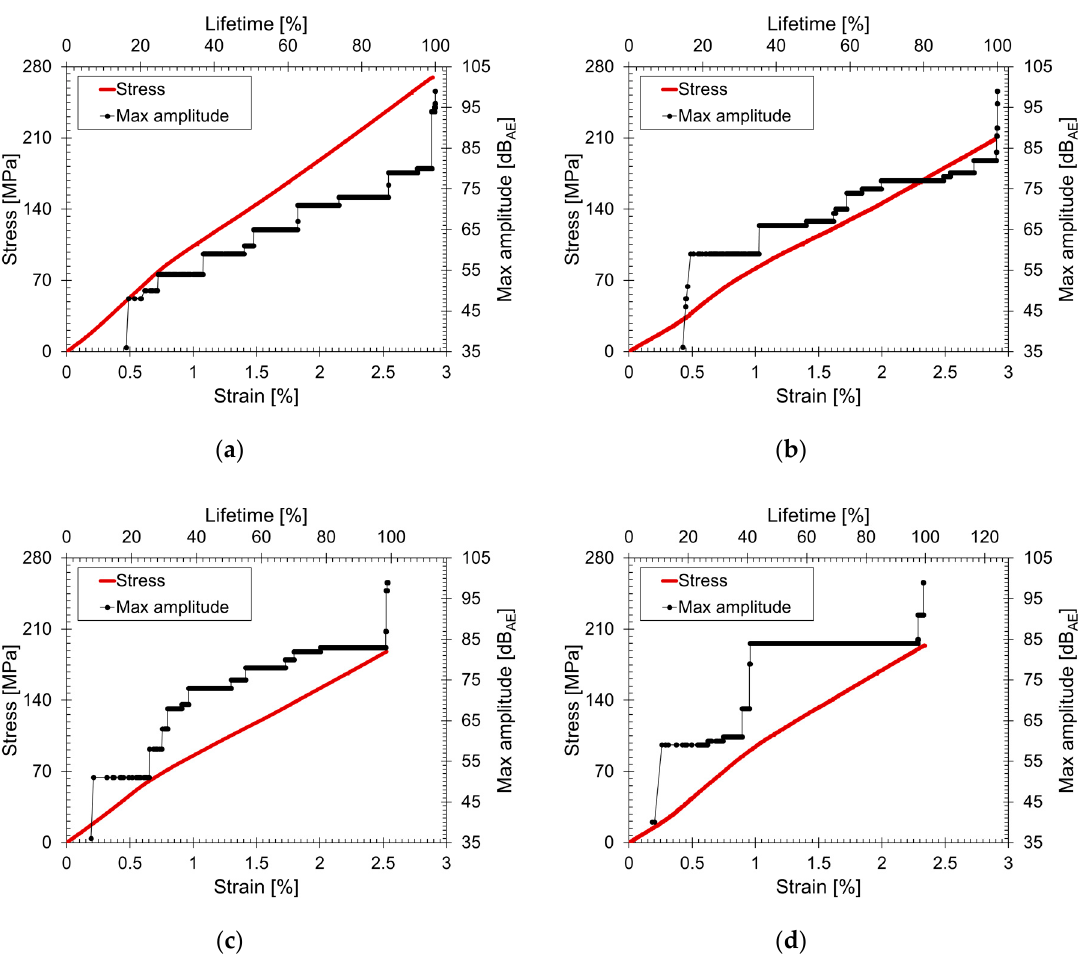
Figure 5. Stress–strain response of GFRP specimens and maximum AE amplitudes after UV irradiation for ( a ) 0 h, ( b ) 100 h, ( c ) 200 h, and ( d ) 300 h.